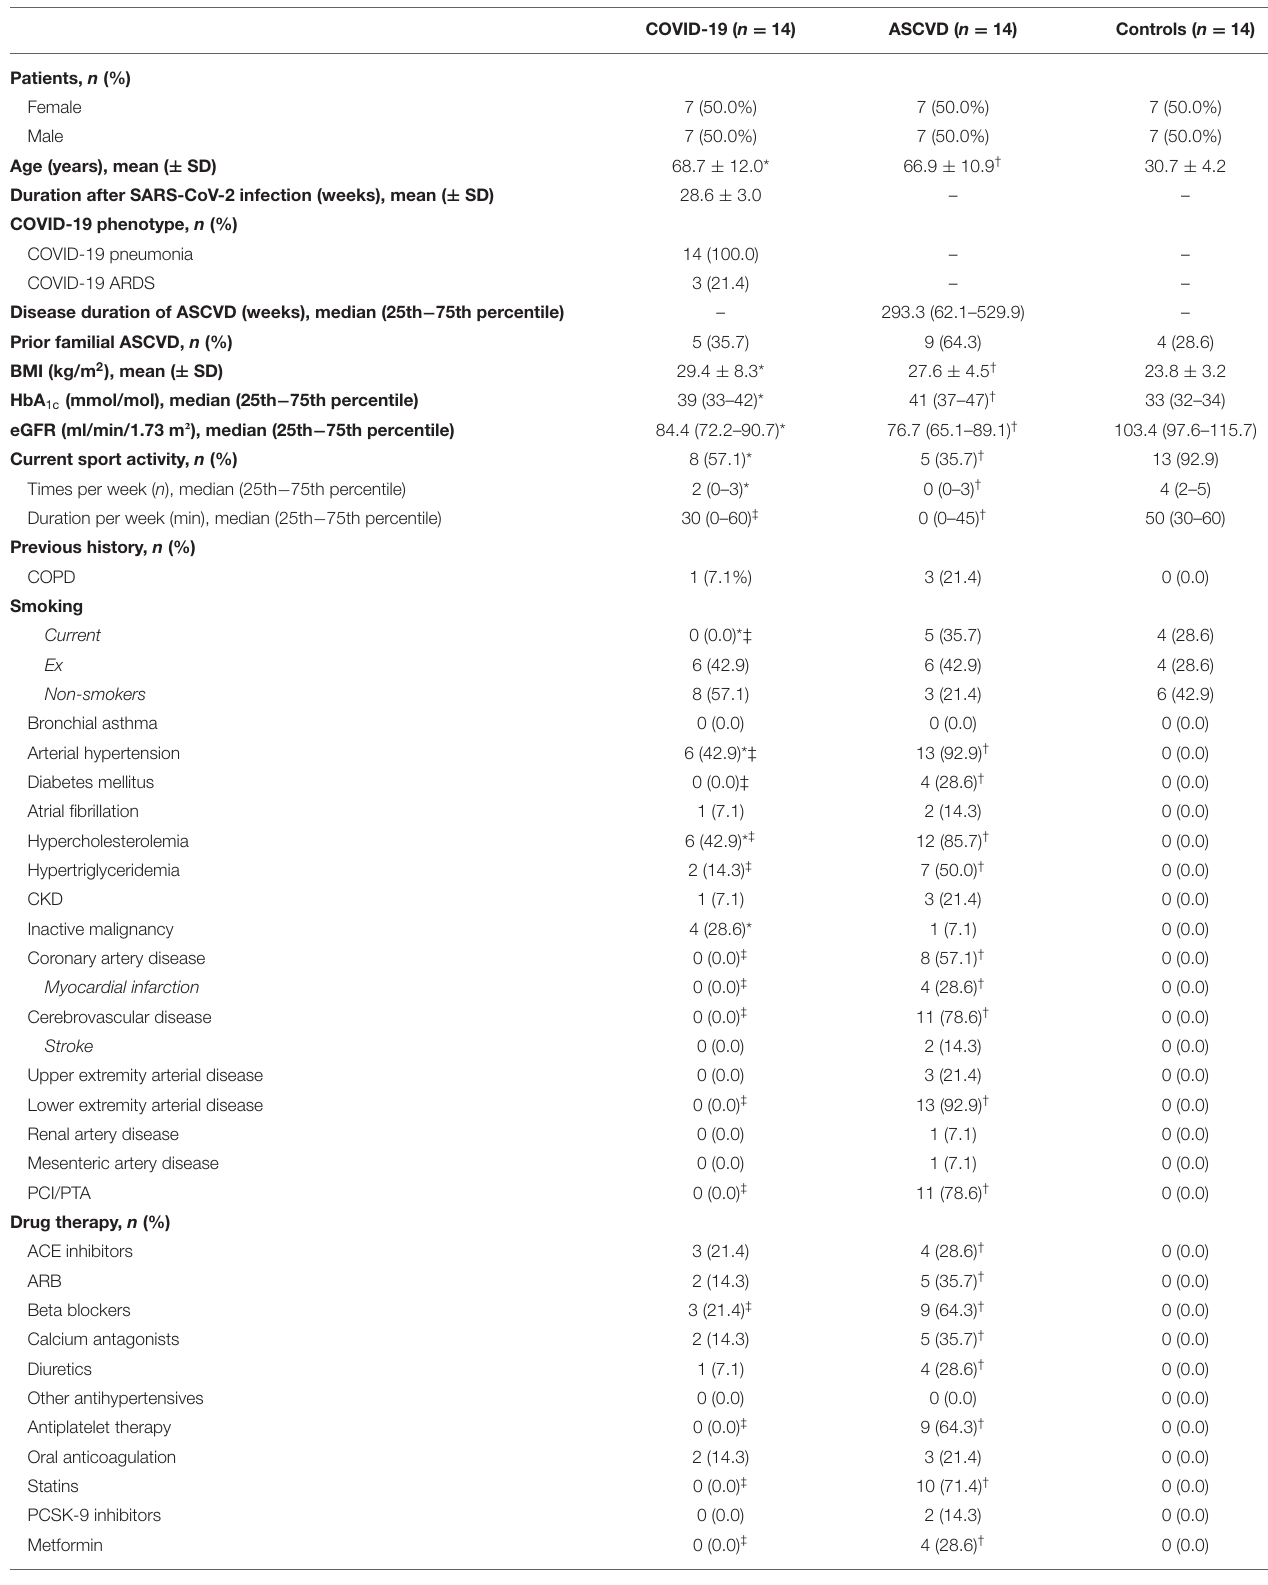
TABLE 2 | Patients’